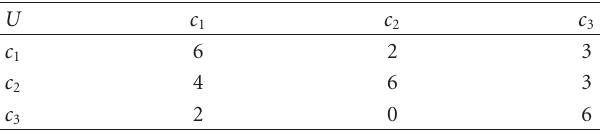
Table 7: Comparison table for truth-membership function.